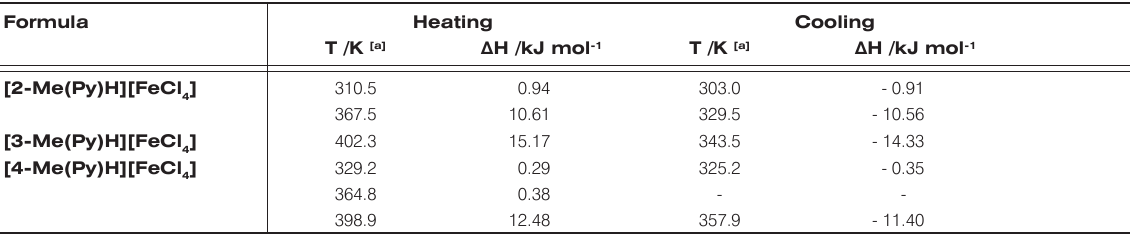
] and [4-Me(Py)H] 4